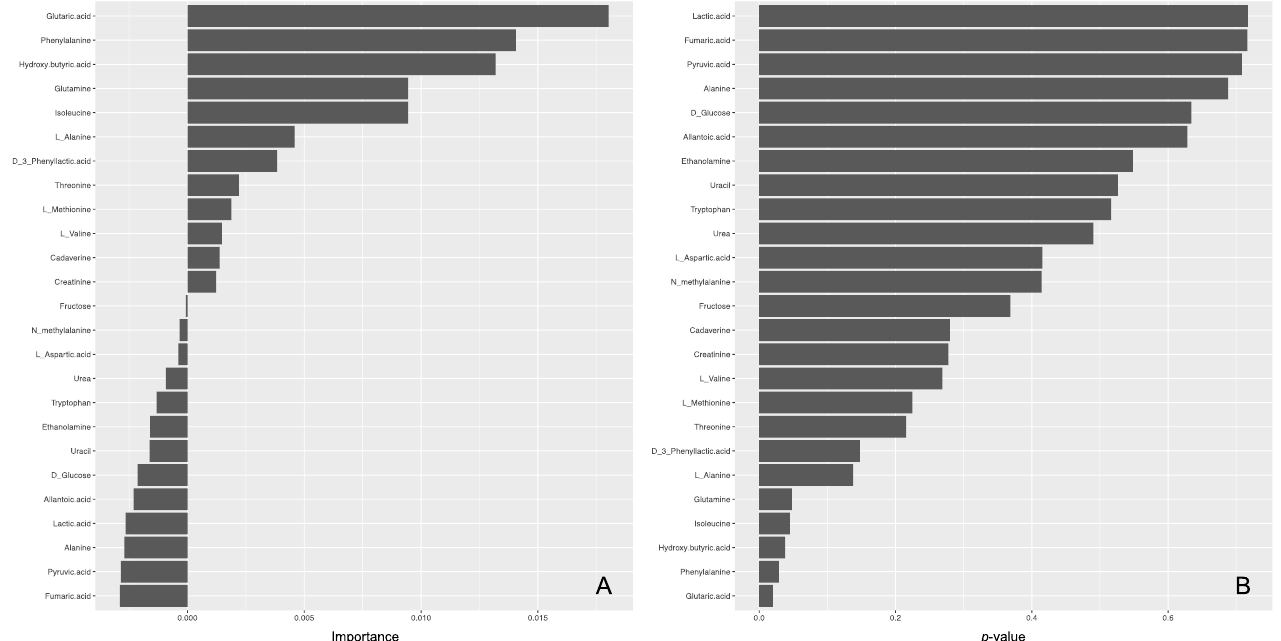
Figure 3. Correlation matrix of the levels of lead in tissue and concentration of metabolites in plasma. The number in each cell indicates the p value, and the colored circle indicates the correlation coefficient.